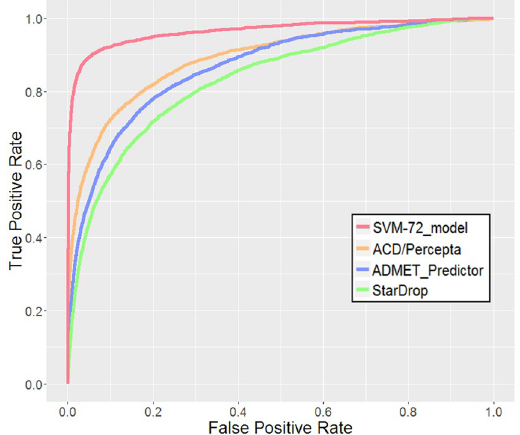
Figure 4. ROC curve of the SVM model, using the 72 descriptors and ECFP_4 (red), as compared to ACD/ Percepta (orange), ADMET Predictor (blue), and StarDrop